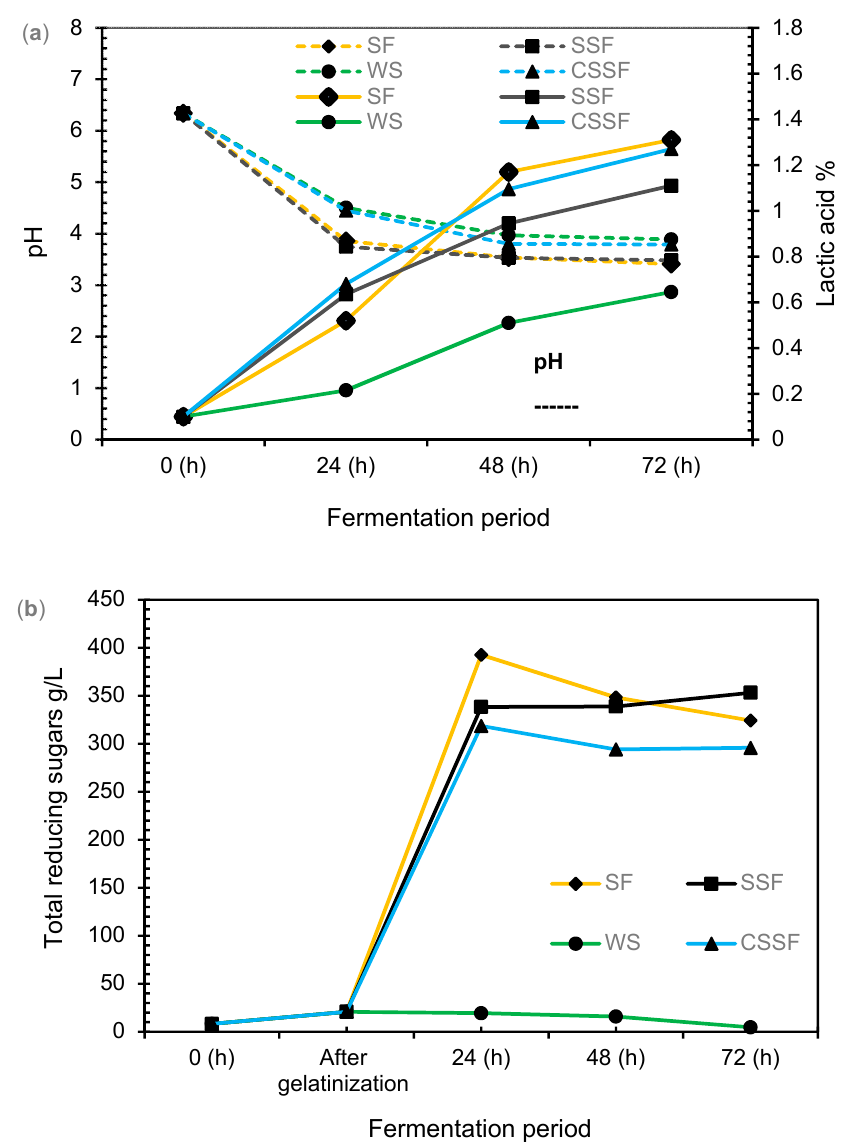
Figure 2. ( a ) Changes of pH during fermentation and ( b ) changes in reducing sugars during simultaneous saccharifications and fermentation (SSF) ( ∎ ), Saccharification then fermentation (SF), ( ◆ ) addition of CaCO 3 (CSSF), ( ▲ ) and without sacchari fi cation (WS) ( ● ).